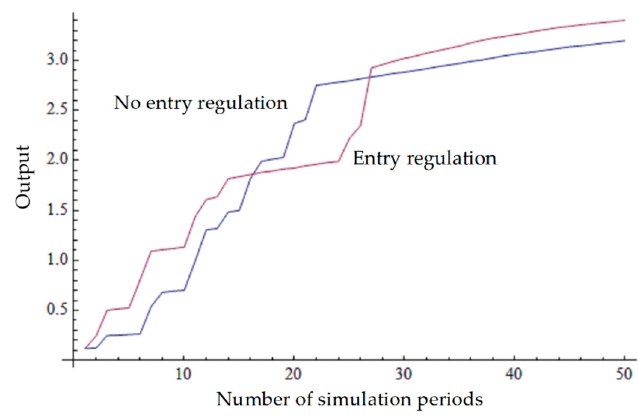
Figure 9. Impacts of entry regulation on fuel ethanol production.